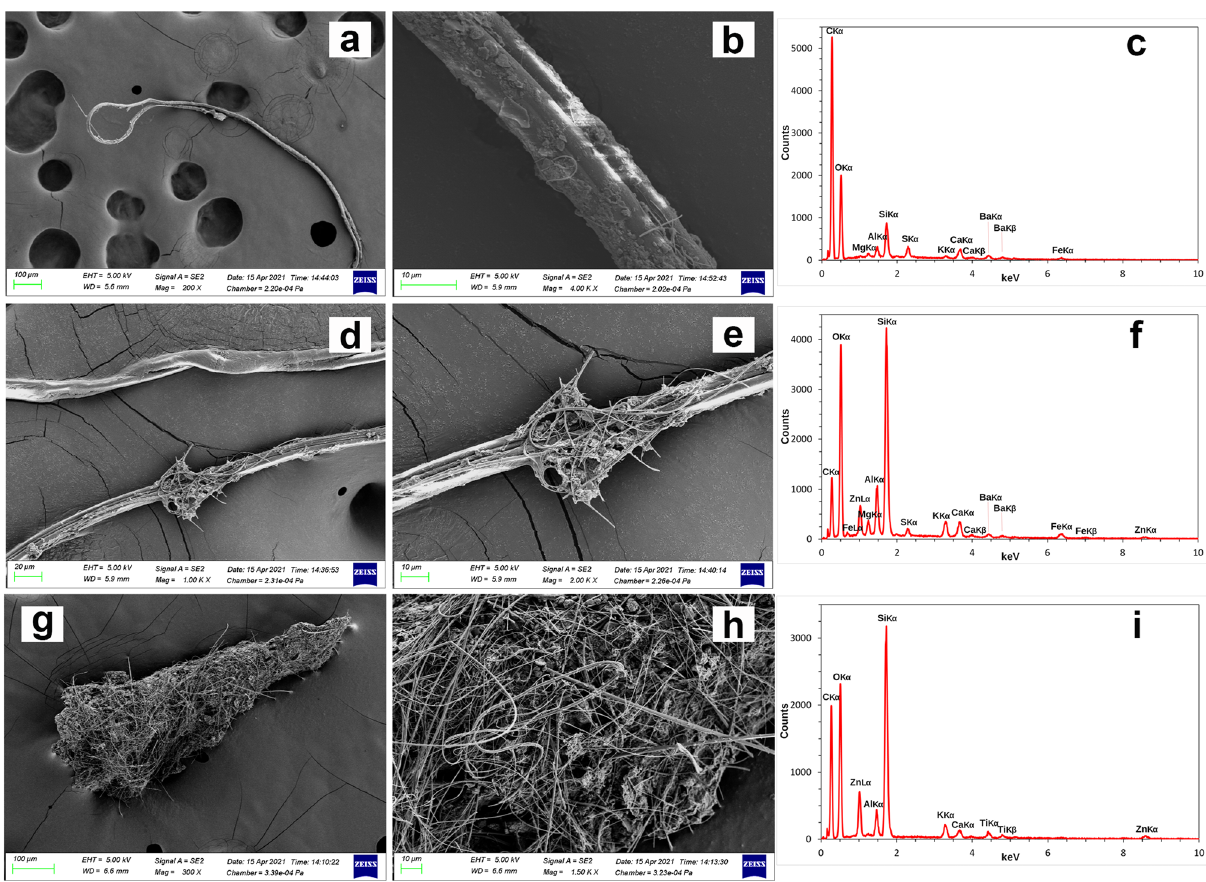
Figure 6. SEM/EDX images and microanalysis from different kind of plastics. SEM images ( a , b , d , e , g , h ) and spectra ( c , f , i ) showing the different kind of microplastics obtained from Bursatella leachii analysed. ( a – c ) Fibreglass fibre containing Carbon and Oxygen as the most abundant elements. ( d – f ) fibReglass fibre showing the Silicon peak and Carbon, Oxygen and several other minor elements. ( g – i ) Fibreglass debris with the Silicon peak followed by Carbon and Oxygen and several other minor